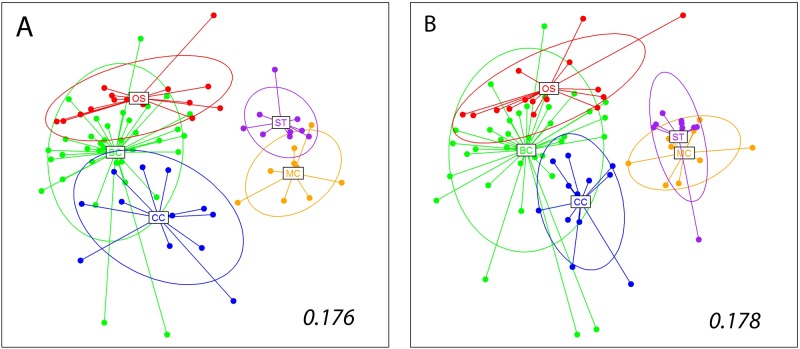
Non-metric Multidimensional Scaling plots of the samples obtained using Jaccard dissimilarity index (A), and Bray-Curtis dissimilarity index (B) for the whole dataset.The centroids for the different zones, and the corresponding inertia ellipses, are indicated. Numbers inside the plots are the stress values of the retained configurations.